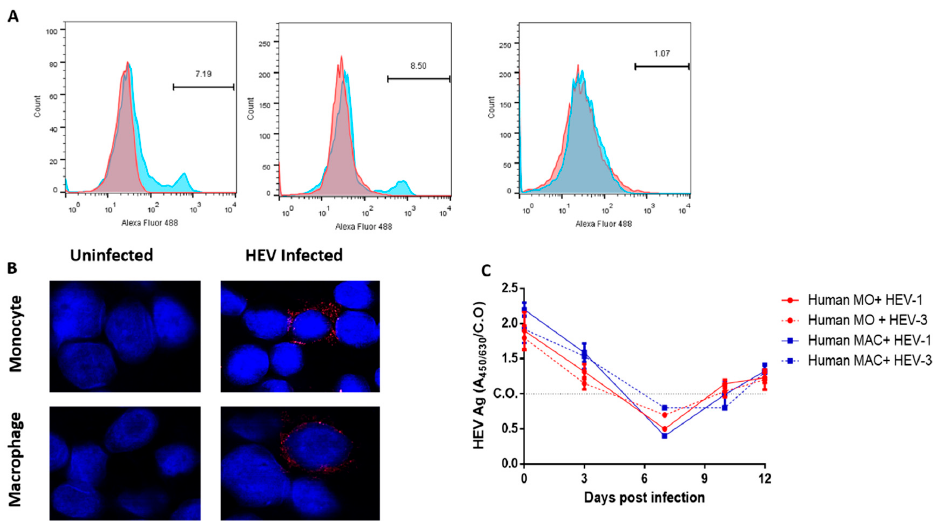
Figure 3. Detection of the HEV capsid protein and ds-RNA in HMOs and HMACs challenged with HEV inoculums ( A ) Representative gating strategy showing the expression of HEV ORF2 Ag in HMOs and HMACs infected with HEV. (left): HMOs infected with HEV-1. (Middle): HMACs infected with HEV-3, and (right): mock infected cells. Red histograms represent cells stained with the secondary A488 conjugated anti-mouse antibodies alone; blue histograms represent cells stained by mouse anti-HEV-ORF2 followed by A488-conjugated anti-mouse antibody. ( B ) Representatives showing HMOs (upper panel) or HMACs (lower panel) either uninfected (left side) or infected with HEV preparations (right side) were fixed and stained with anti-ds-RNA (J2 Ab) (red). DAPI was used for nuclear staining (blue) (Scale bars, 20 μ m). Representative showing infection of HMOs with HEV-1 and infection of HMACs with HEV-3. ( C ) Supernatants collected from HEV-1 (solid line) and/or HEV-3 (dotted line)-infected HMOs (red) and HMACs (blue) were tested for HEV ORF2 Ag by ELISA, C.O is the cut off. Depicted are the mean values of three independent experiments ± SEM.